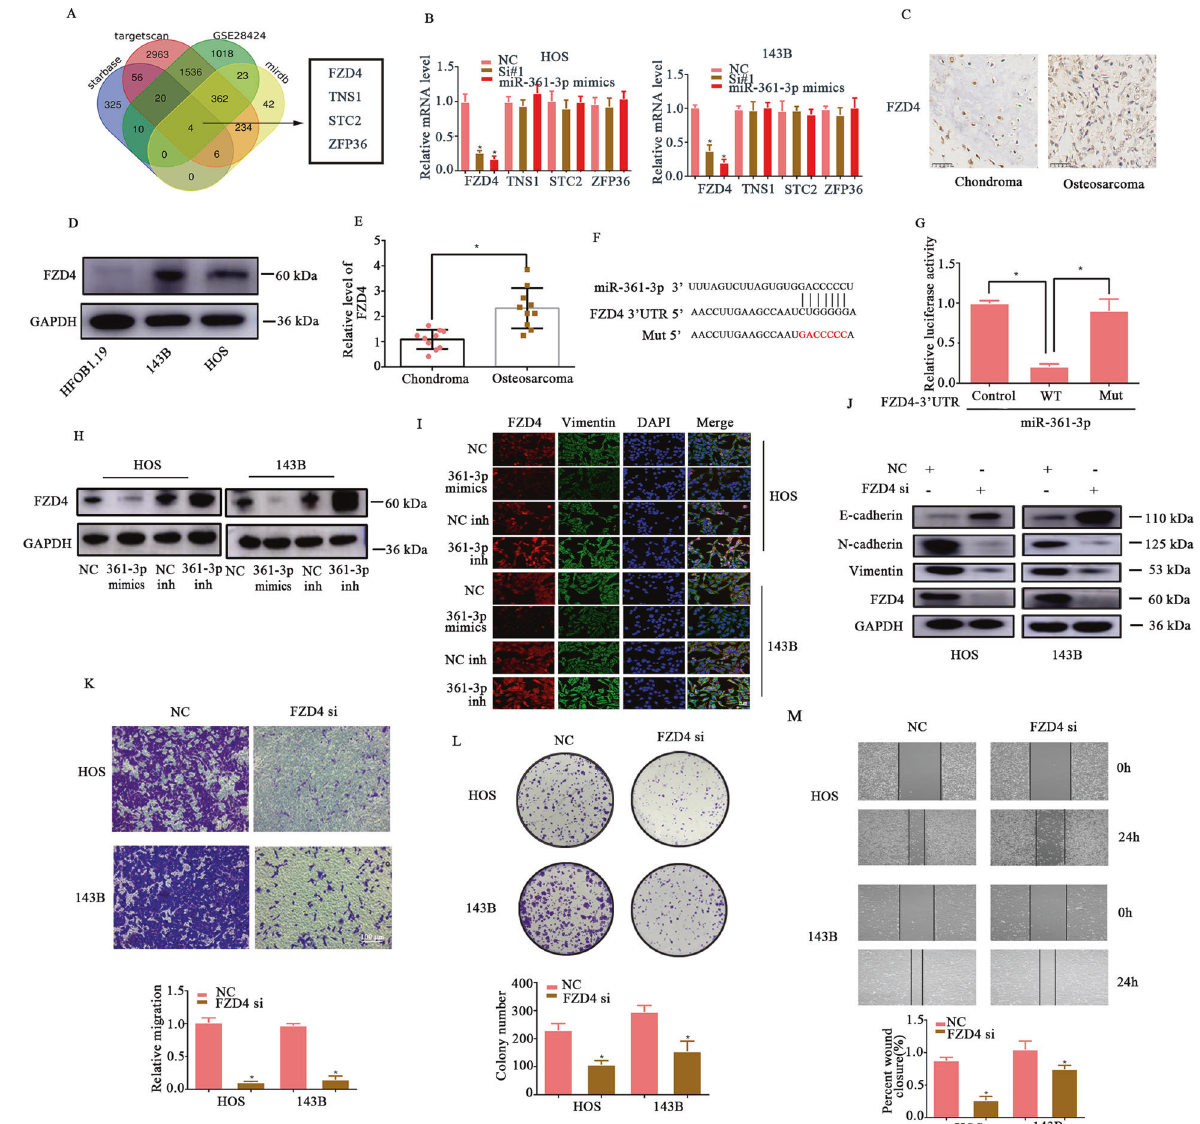
Fig. 4 FZD4 is a direct target of miR361-3p. A Schematic illustration exhibiting the overlapping of the target genes of miR-361-3p predicted by starBase, TargetScan, GSE28424 and miRDB. B Four upregulated genes were subjected to RT-qPCR in HOS and 143B cells transfected with either Si1-circPRKAR1B or miR-361-3p mimics. C Immunohistochemistry (IHC) results showing that FZD4 expression was upregulated in OS tissues compared with chondroma tissues. D The protein expression of FZD4 measured detected by Western blot analysis in both HOS, 143B and HFOB1.19 cells. E RT-qPCR demonstrated a difference in the expression of FZD4 at the mRNA level between osteosarcoma and chondroma tissues ( n = 10). F Schematic illustration of the complementary sequence between miR-361-3p and FZD4. Mutated nucleotides in the FZD4 3 ′ UTR are shown in lowercase letters. G HEK-293T cells were transfected with miR-361-3p mimics or NC and the wild-type or mutated FZD4 3 ′ -UTR reporter and subjected to the luciferase assay. OS cells were stably transfected with miR-296-3p mimics and a miR-296- 3p inhibitor. FZD4 expression was measured by Western blotting ( H ) and IF ( I ) at the protein level. J The protein levels of β -catenin, cyclin D1, C-myc, E-cadherin, N-cadherin, vimentin and FZD4 in OS cells when FZD4 was knocked down. K The cell migration abilities of HOS and 143B cells transfected with NC or si-FZD4 were evaluated by Transwell migration assays. L Colony formation assay showing changes in the proliferative capacity of OS cells stably transfected with NC or si-FZD4. M Representative images showing the effect of FZD4 knockdown on migration ability, as demonstrated by the wound-healing assay. The data represent the mean ± SD ( n = 3) (* P <